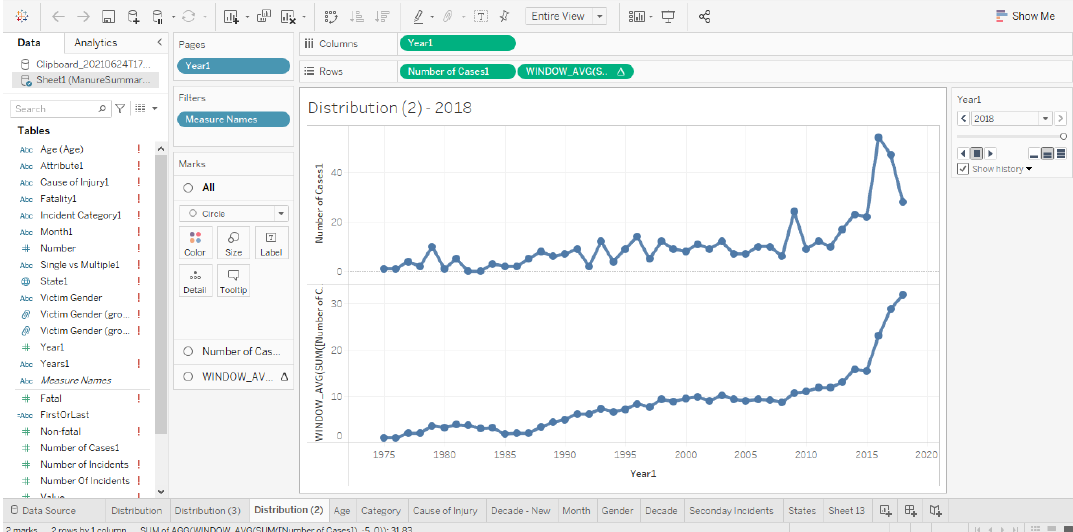
Figure 12. Dashboard software display of agricultural waste injury and fatality